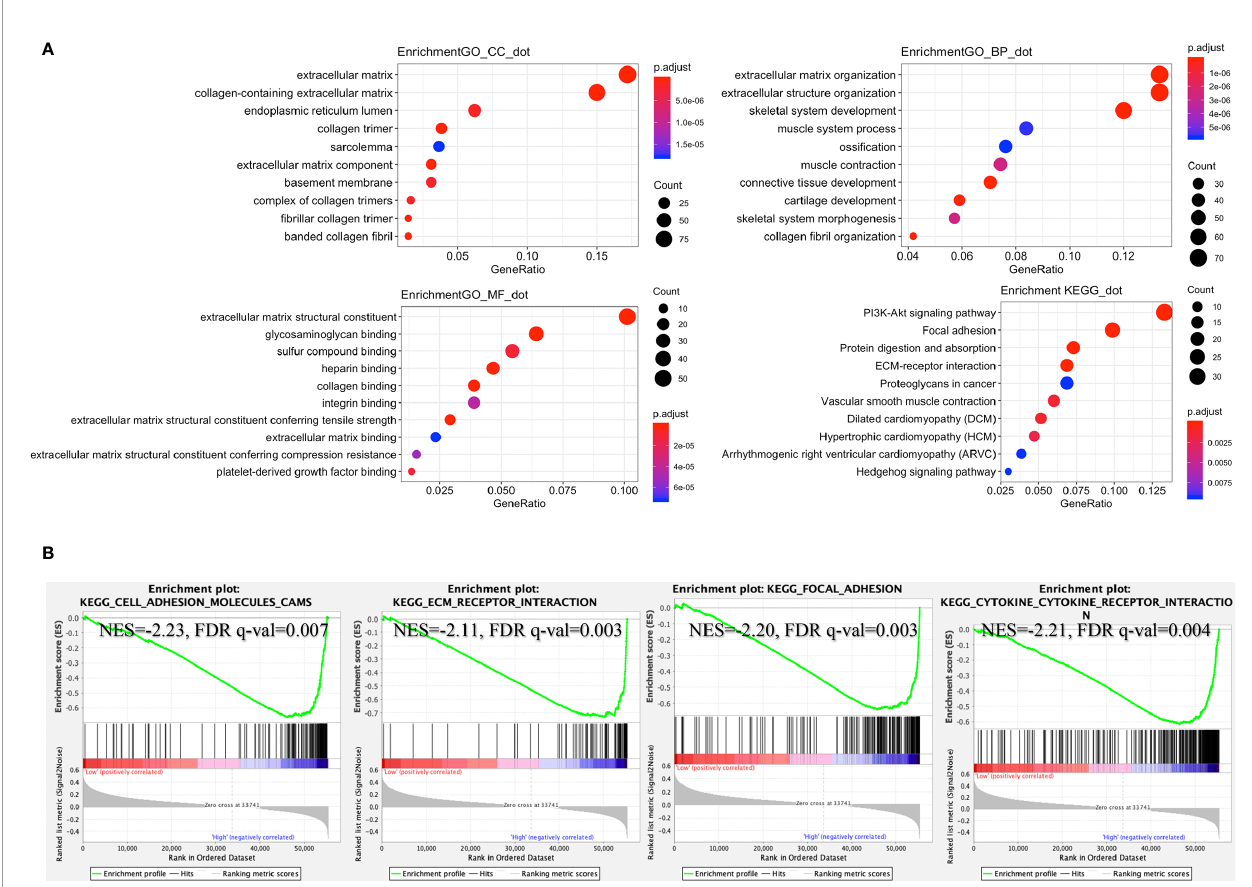
FIGURE 5 | Enrichment of signaling pathways in the high-risk group. (A) According to the risk score, GO and KEGG signaling pathways were explored by R packages “ clusterPro fi ler ” and “ DOSE. ” (B) Gene set enrichment analysis (GSEA) indicated that “ cell adhesion molecules cams ” , “ ECM receptor interaction ” , “ focal adhesion ” , and “ cytokine-cytokine receptor interaction ” were enriched in the high-risk group (GSEA version 4.0.3,